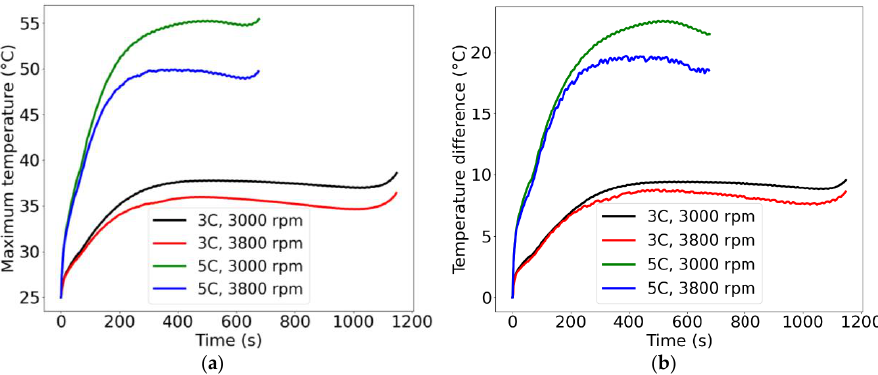
Figure 10. Temperature histories of the battery module at various fan speeds: ( a ) maximum temperature curves and ( b ) temperature difference curves.